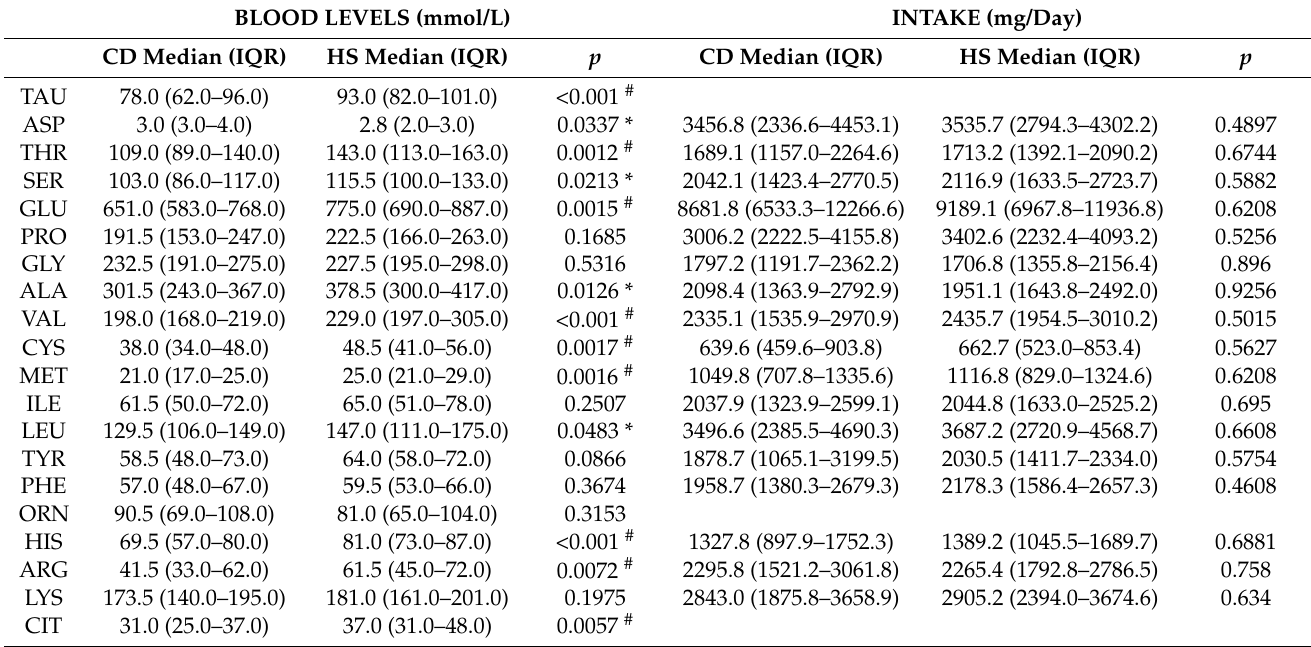
Table 3. Blood levels of amino acids compared with intake